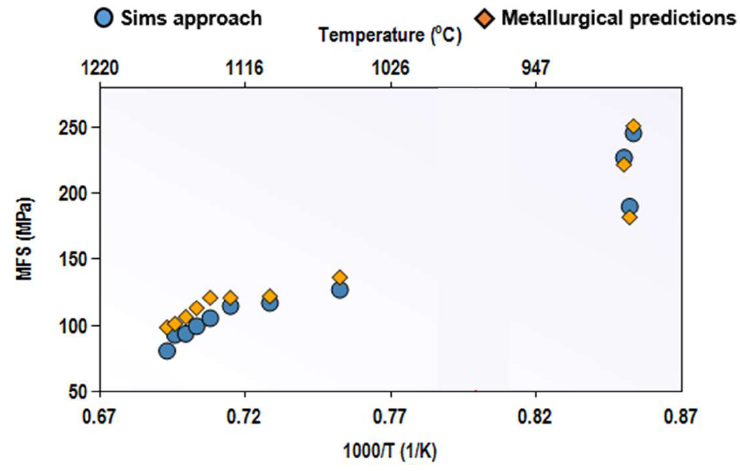
Figure 5. Mean Flow Stress (MFS) calculations and MicroSim-SM ® predictions for optimized rolling sequence. Blue dots refer to MFS calculations based on rolling mill loads (Sims model) while yellow dots are the MFS metallurgical predictions based on Misaka-type models.